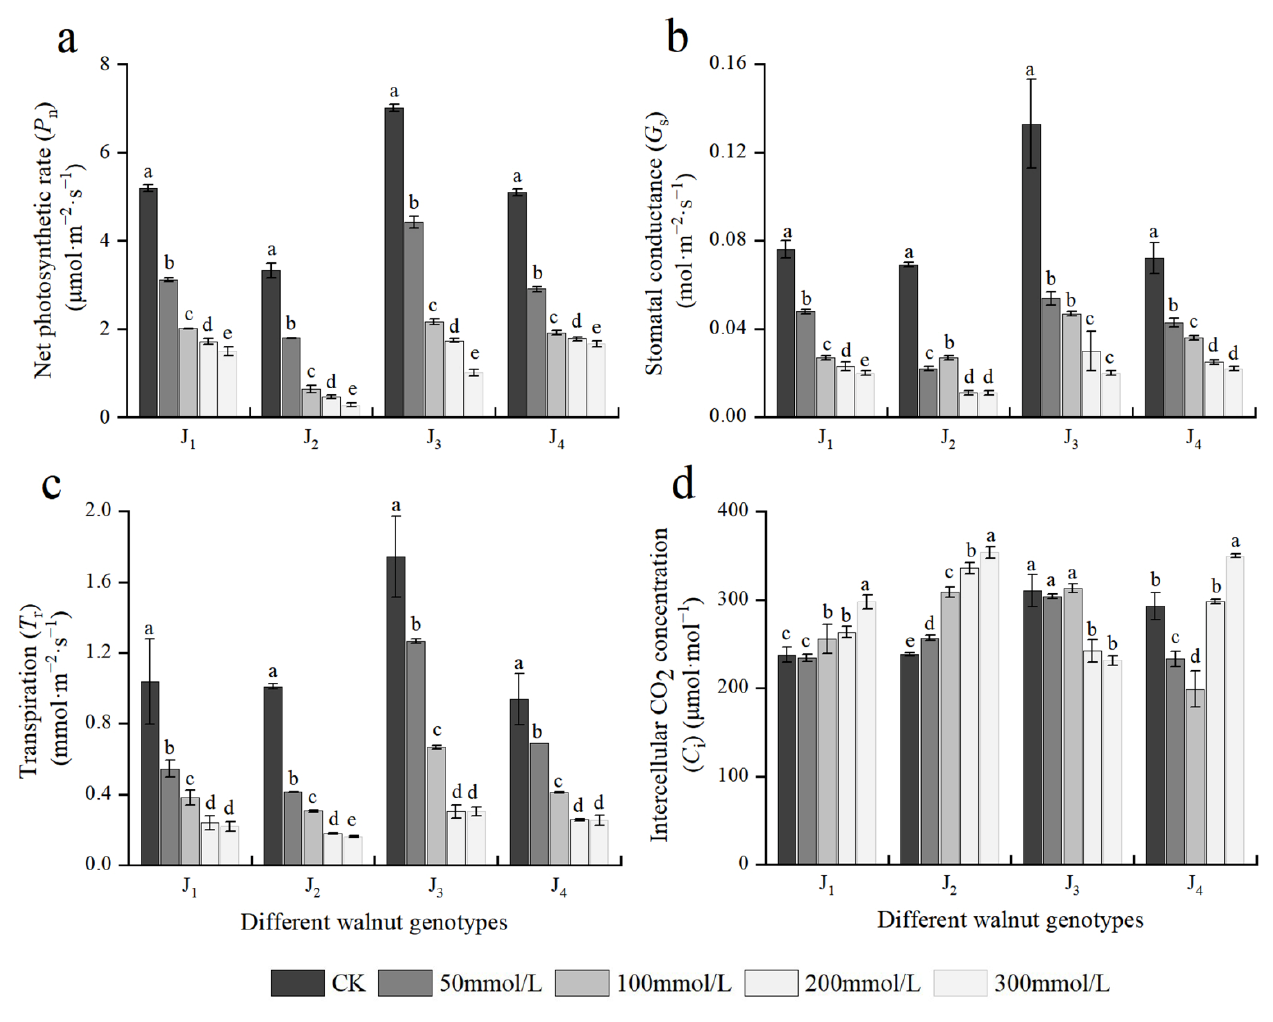
Figure 4. Effect of salt stress on the photosynthetic parameters of walnut. ( a ) Net photosynthetic rate ( P n ), ( b ) stomatal conductance ( G s ), ( c ) transpiration ( T r ), and ( d ) intercellular CO 2 concentration ( C i ) in the leaves. Four walnut genotypes were grown under different NaCl concentrations (0, 50, 100, 200, and 300 mmol/L) for 28 days. Each value indicates the mean ± standard error (SE) of three biological replicates. Bars of each parameter labeled with different letters are significantly different ( p < 0.05) by Duncan’s